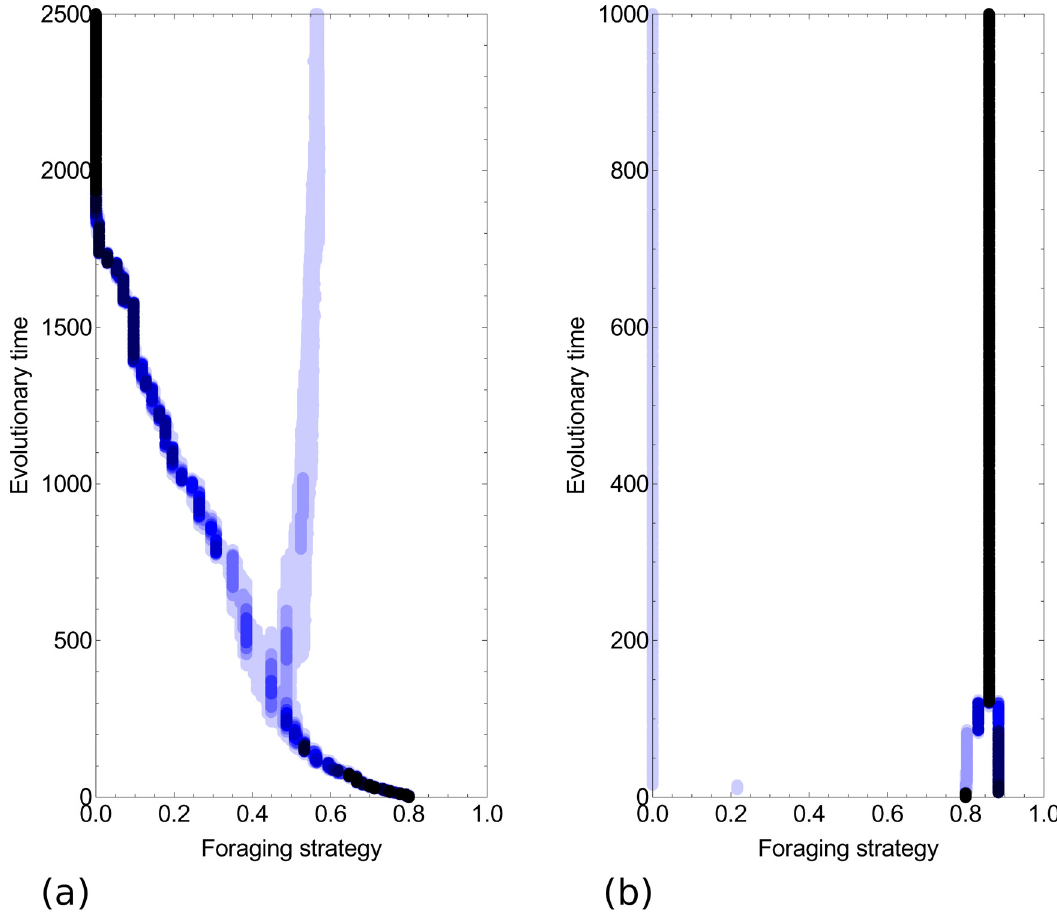
Fig 9. Simulated evolutionary trees for: a) strategies emerging from small-scale mutation-selection processes ( var where food item density ρ = 0.986 and b) strategies emerging from introduction ( var G = 1), where food item density ρ = 0.8. Line darkness reflects the relative number of colonies in the population using the corresponding strategy. All the simulations started with a monomorphic community of mass recruiting species ( x r = 0.8). The degree of competition asymmetry ϕ = 5. The ecological timescale was assumed to be 10 5 times faster than the evolutionary timescale. Here, b = 0.1 and μ = 0.001.